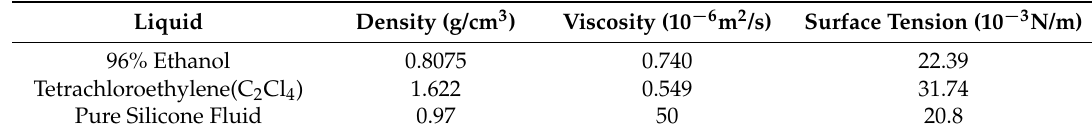
Table 4. Physical properties of liquid used in measurement.